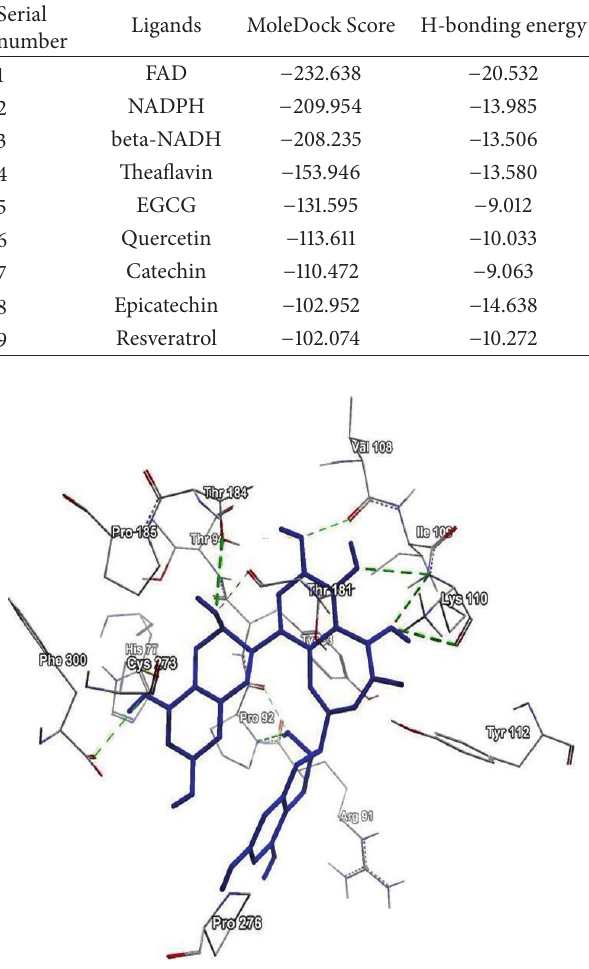
Figure 5: Low energy bound conformation of theaflavin in hydro- gen bonding view with interacting amino acids of Human NADH- cytochrome b5 reductase protein at the active site